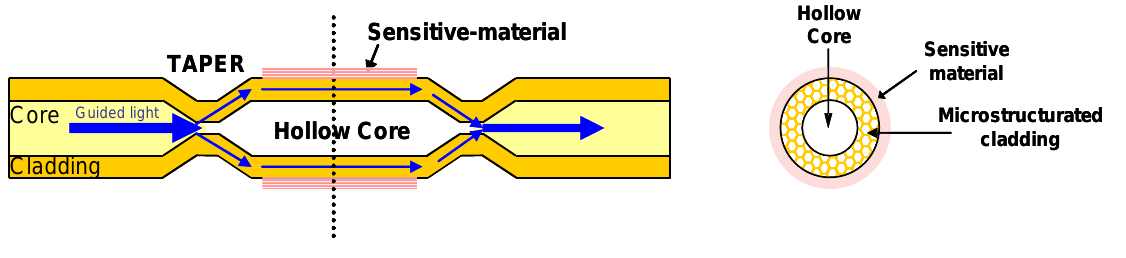
Figure 9. Hollow core fiber with microstructurated cladding, connected between two standard multimode optical fiber sections. A sensitive material can be also fixed onto the